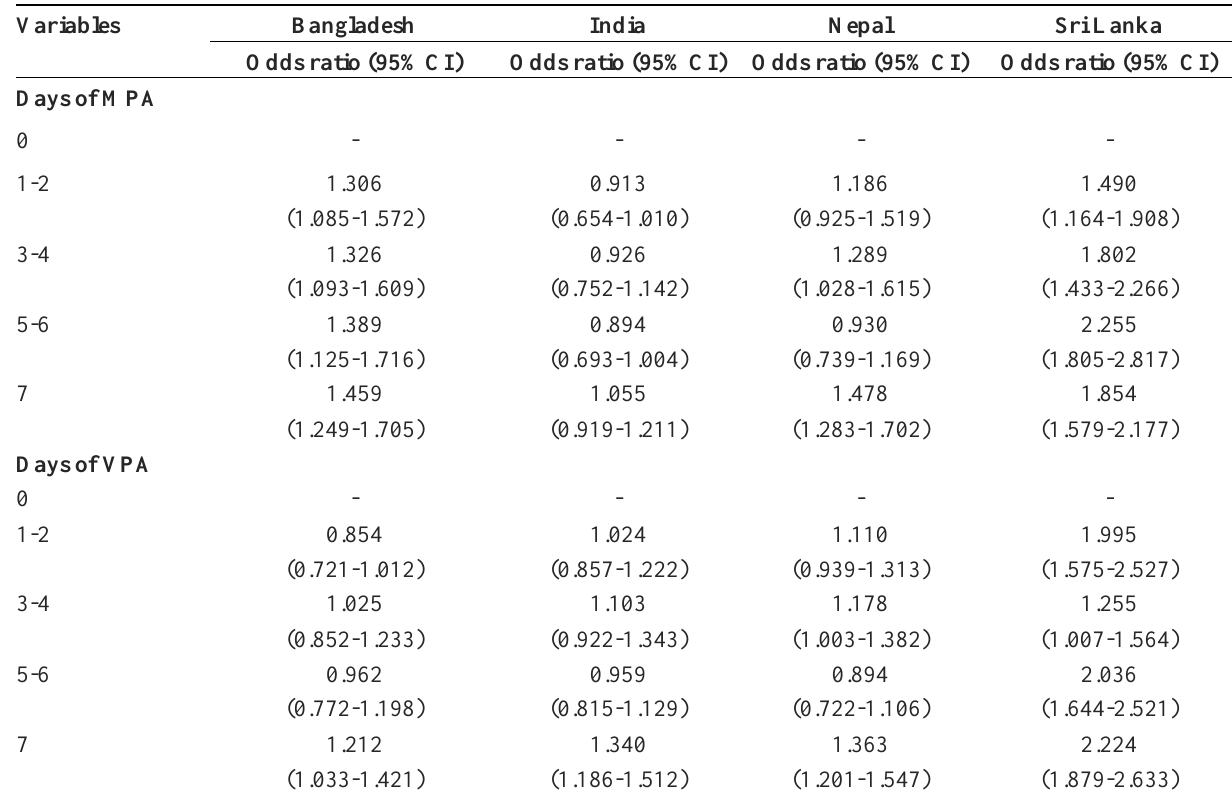
Table 3. Multivariable analysis on the association between PA and SRH in selected South Asian countries, WHS